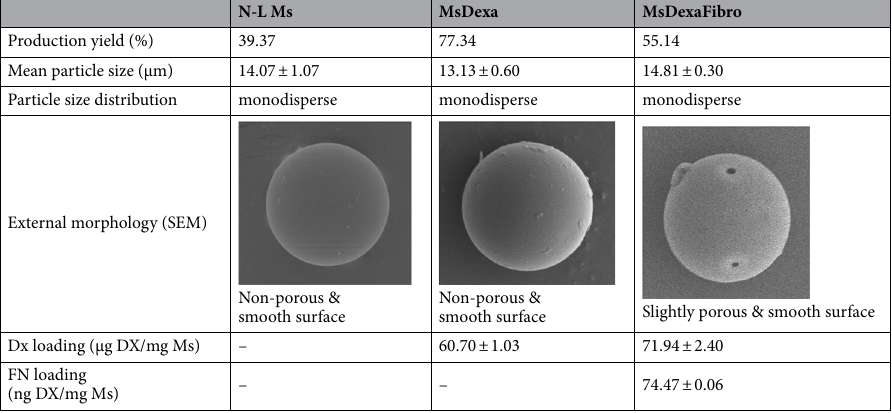
Table 1. Physical and chemical characterization of the microsphere formulations used to create the different ocular hypertension animal models. Production yield (%); Mean particle size and particle size distribution, external morphology ( SEM : scanning electron microscopy; Jeol, JSM-6335F, Tokyo, Japan), dexamethasone loading (µg DX/mg Ms) according to direct quantification after extraction from the microspheres (Ms), and fibronectin loading (ng FN/mg Ms) indirectly obtained as the final point of cumulative release in the in vitro release